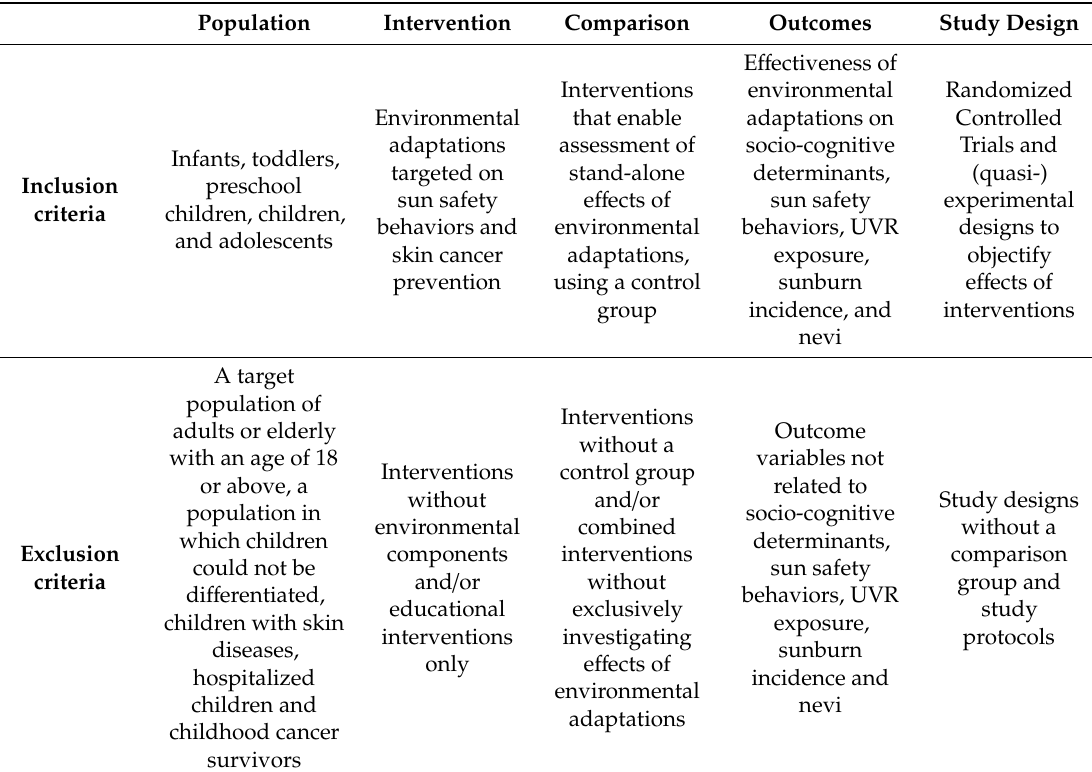
Table 1. Index terms (PICOS), inclusion, and exclusion